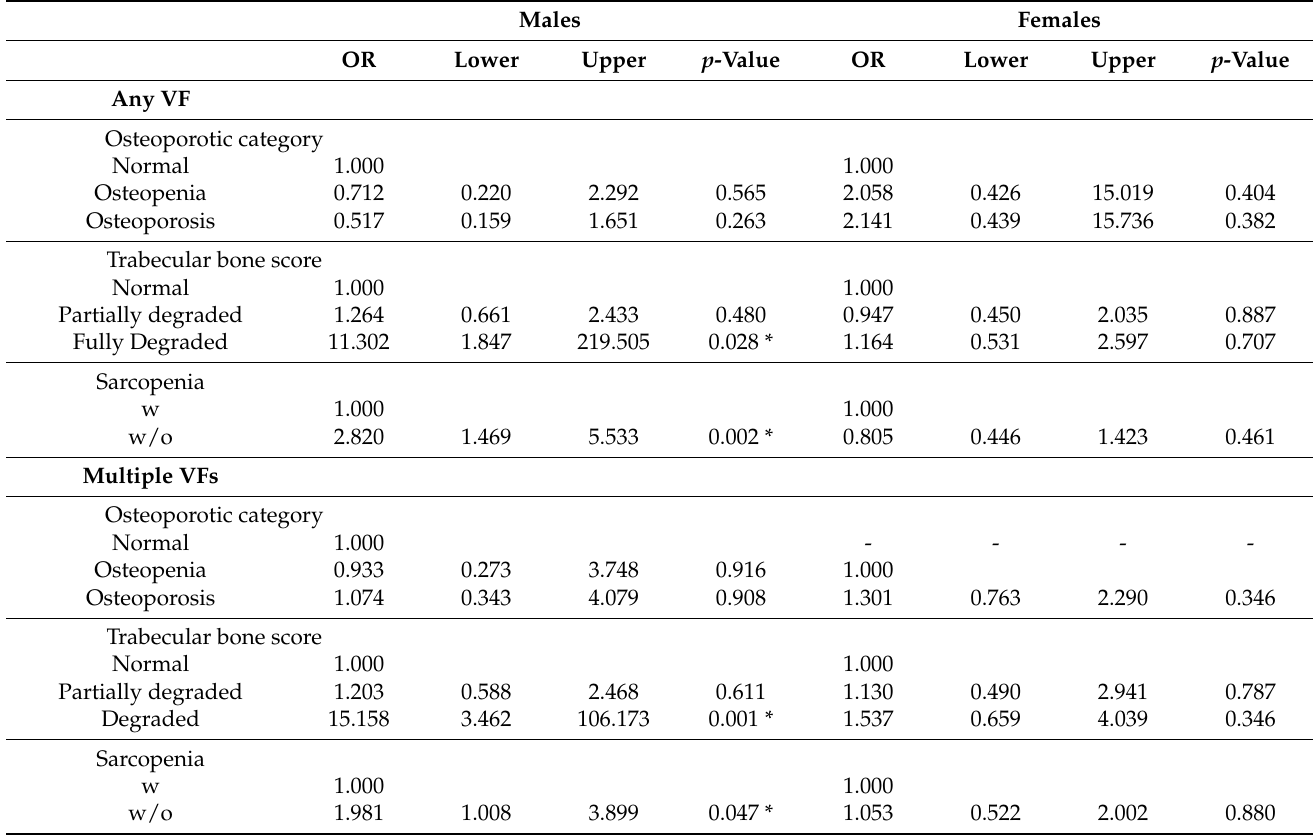
Table 4. Predictive power of different parameters for vertebral compression fracture (VF). Males Females OR Lower Upper p -Value OR Lower Upper p